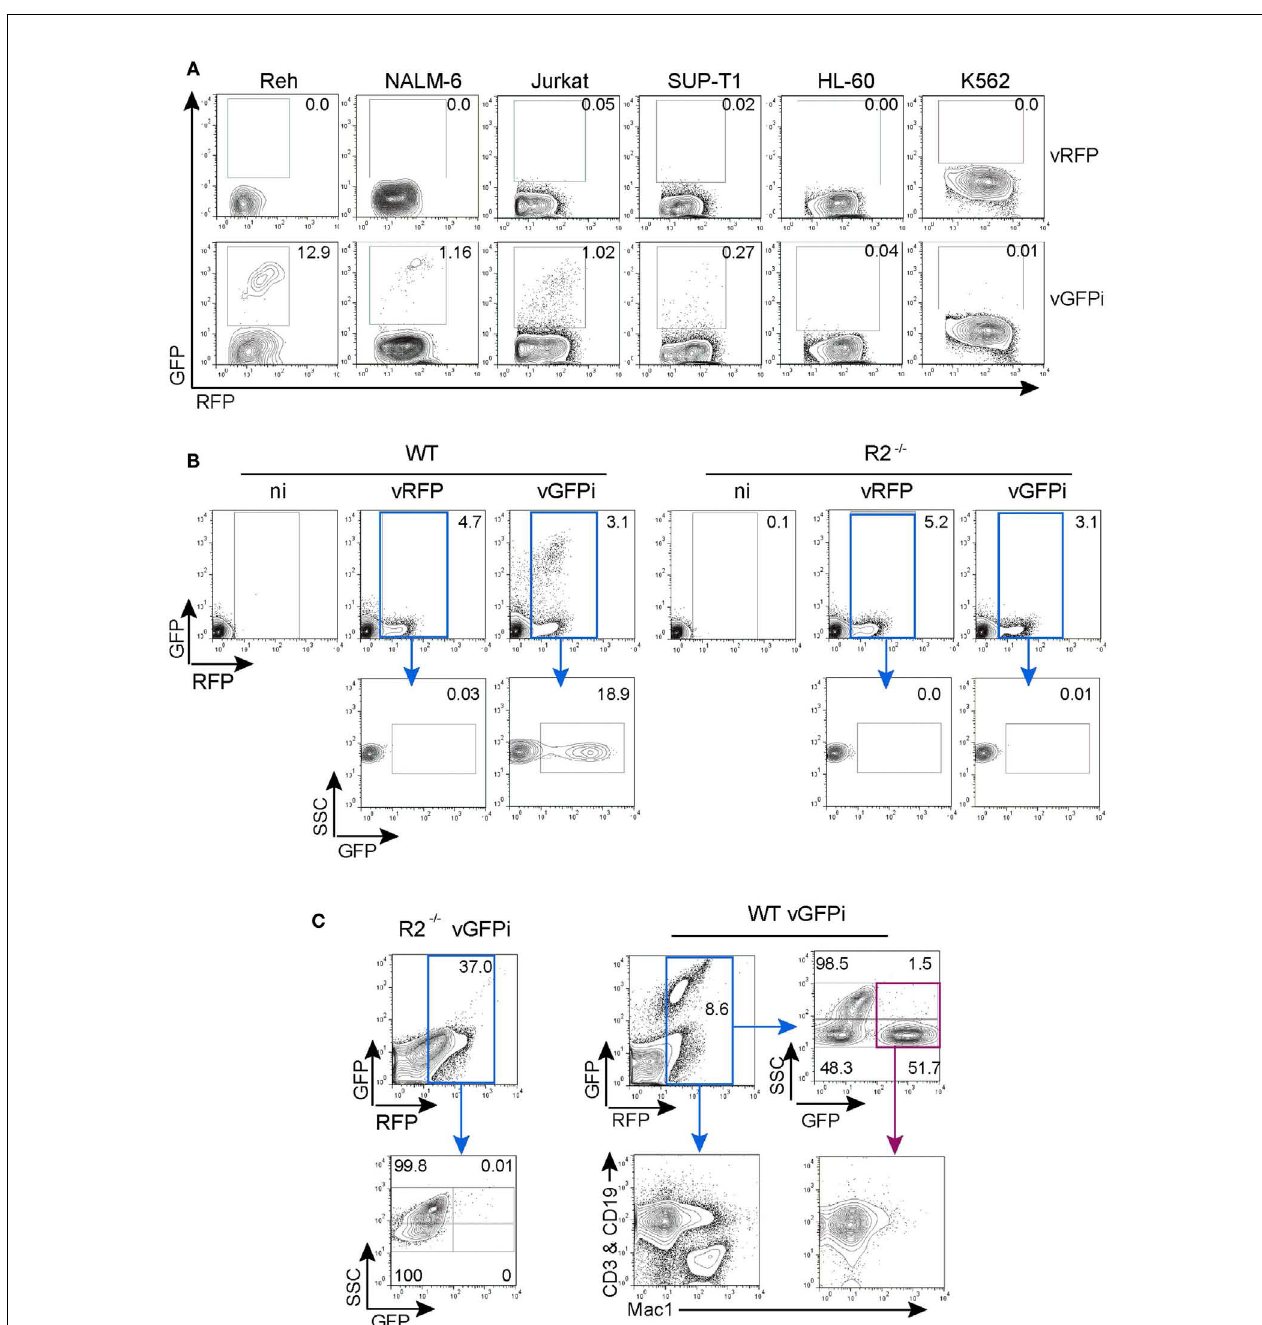
5-FU-treated R2 − / − orWT C57BL/6 mice after transduction with the GFPi or the RFP retrovirus. Shown are representative contour plots ( n = 3 for each type of chimeras) of peripheral blood cells analyzed by FACS 7weeks post-transfer. A first gate, not shown, identified the mononuclear cell population according to the forward and side-scatter physical parameters. Cells were then analyzed for RFP and GFP expression, gated on RFP + cells (blue gate) and reanalyzed for SSC and GFP.The SSC high subset is enriched in myeloid cells, while the SSC low population are enriched in lymphoid cells. For WT cells, RFP + cells were also analyzed for the distribution of lymphocytes (CD3 + or CD19 + ) by co-staining in the same channel (PE) vs. macrophages/myeloid cells (MAC1/CD11c + ). Analysis of GFP bright RFP + (purple gate) for the same lineage markers documents rearrangement in